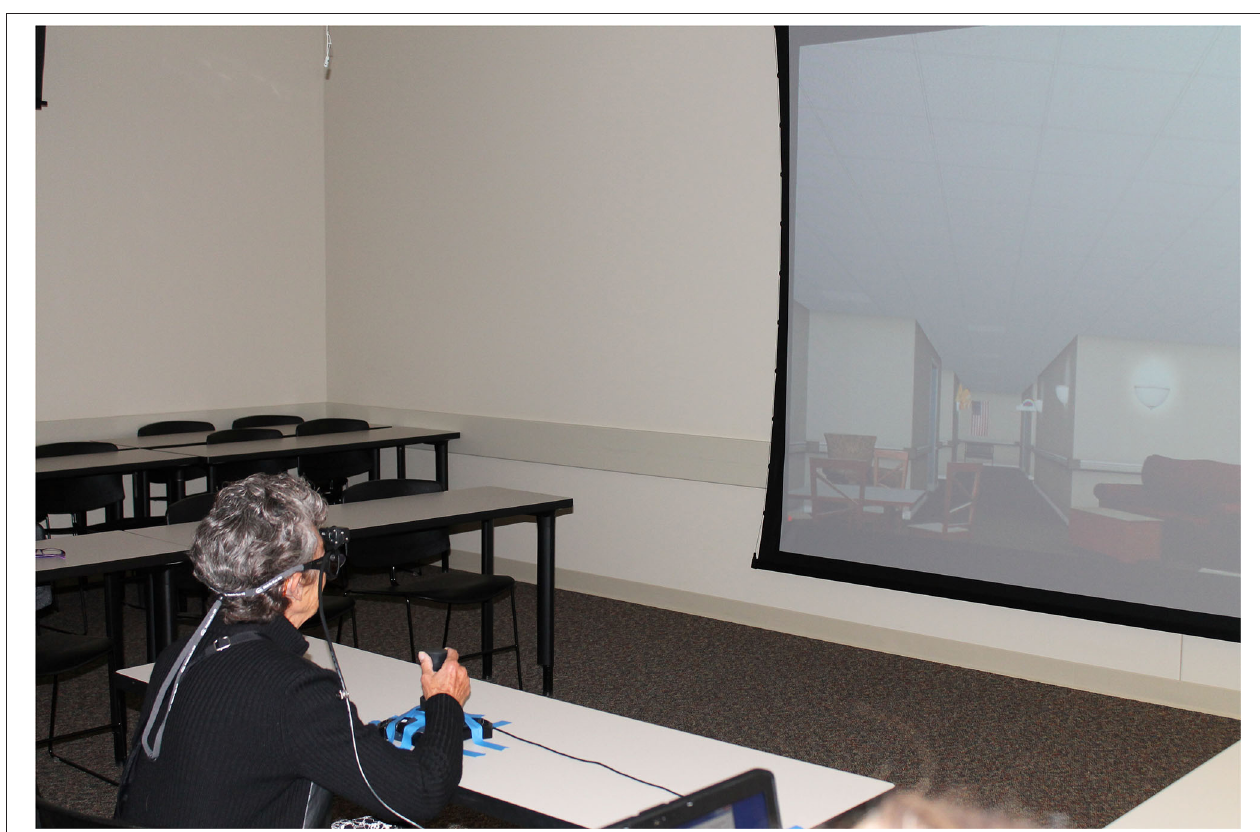
FIGURE 1 | Projected virtual reality spatial navigation test with eye